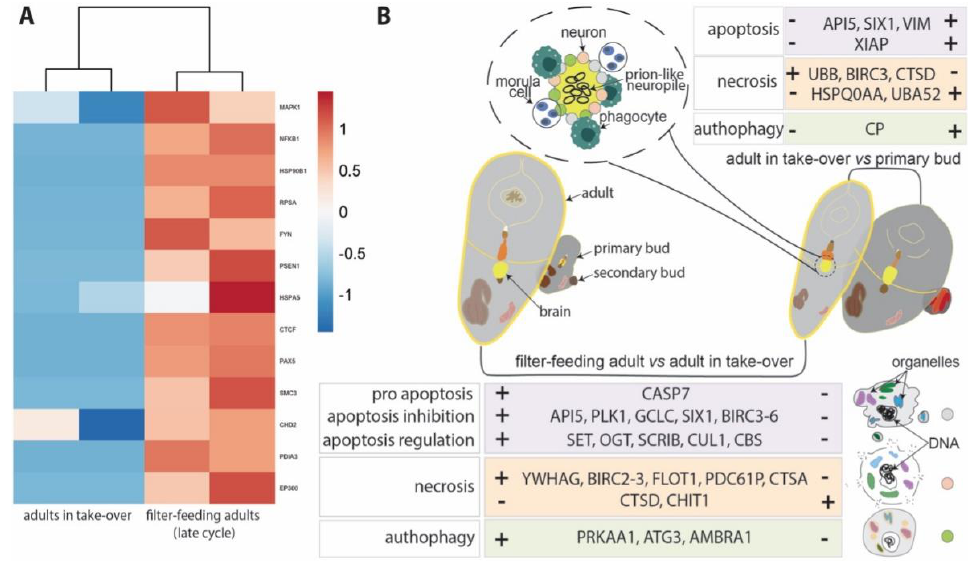
Figure 7. ( A ) Differentially expressed genes associated with prion diseases. Categories are based on the link that each gene has with a neuronal cell death type. The color scale depicts log2CPM normalized expression values scaled by row. ( B ) Key genes involved in the apoptosis, necrosis and autophagy pathways differentially expressed between the filter-feeding adults and adults in takeover (lower box) and between the adults in takeover and the buds (upper box). The illustration on the top shows a brain during takeover composed of a few neurons (gray) and surrounded by phagocytes (green) and morula cells (pink). On the bottom right, the 3 illustrations graphically summarize the 3 different kinds of neuron death.